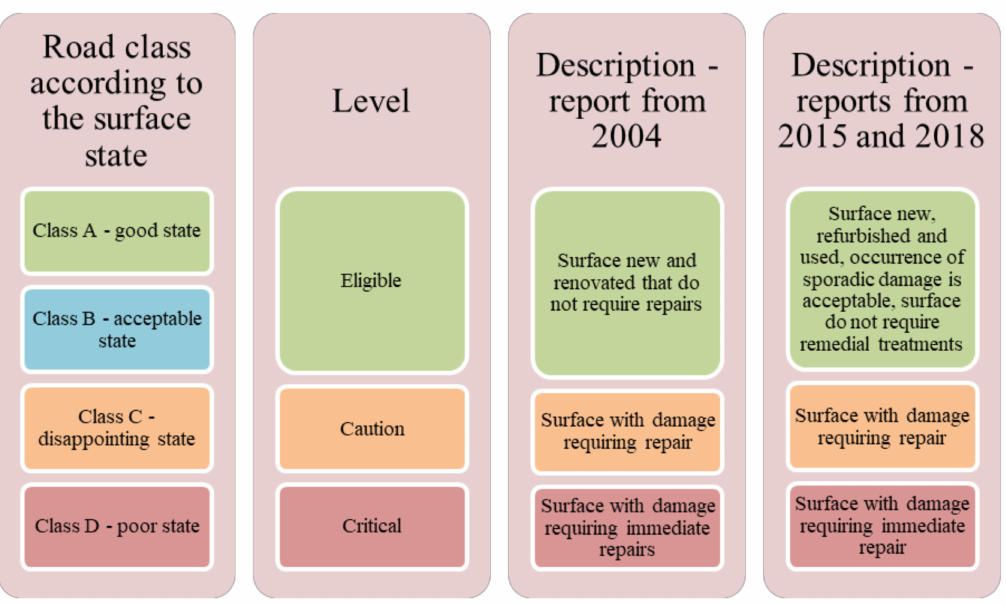
Figure 5. Road classification based on their technical condition Source: the authors, based on [64]. Among the indicators considered, the indicator of immediate repair needs (Irn) in the provinces was assessed, where ‘immediate needs’ concern road sections in bad condition (class D) [64]. According to data referring to the state of roads in the Polish provinces compared with the use of carthographic methods, Figure 6 presents a comparison of Irn acquired from the three mentioned reports (from 2004, 2015 and 2018).